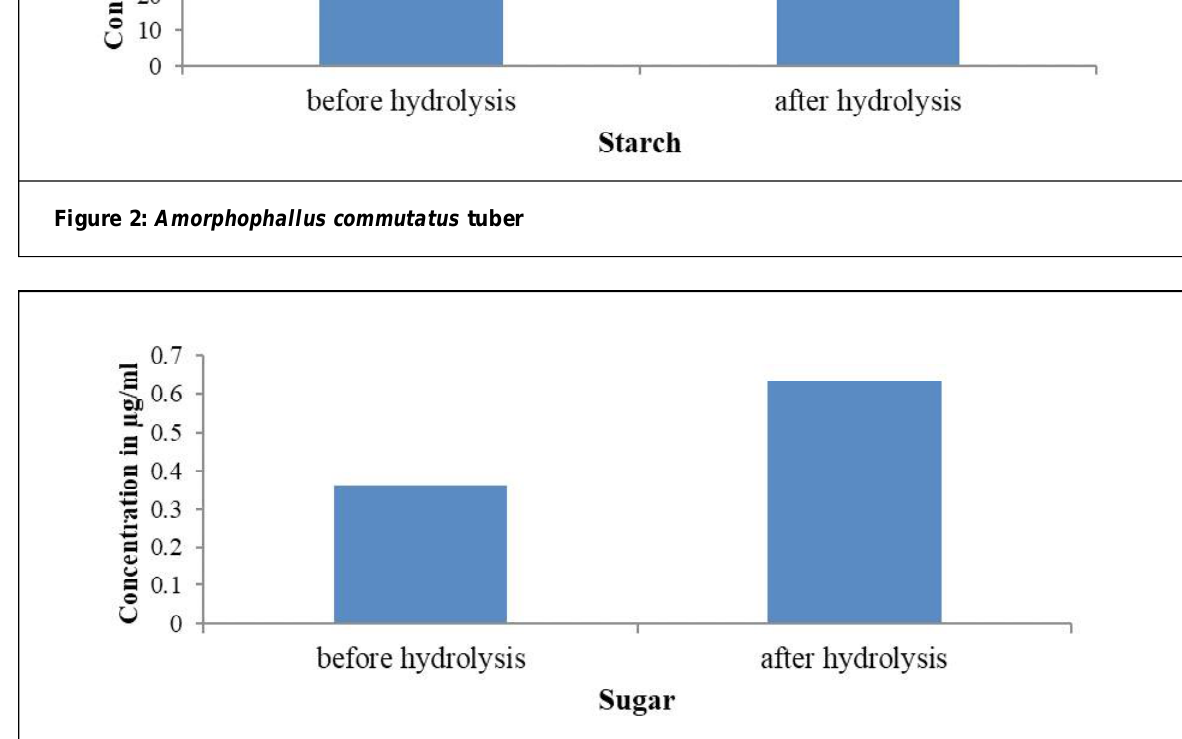
Figure 3: Estimation of sugar in Amorphophallus commutatus